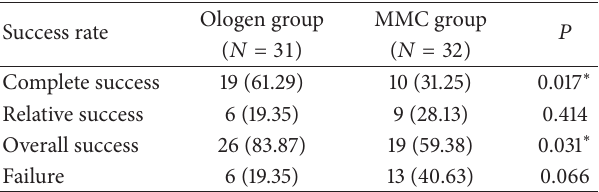
Table 4 provided an overview of the recorded side